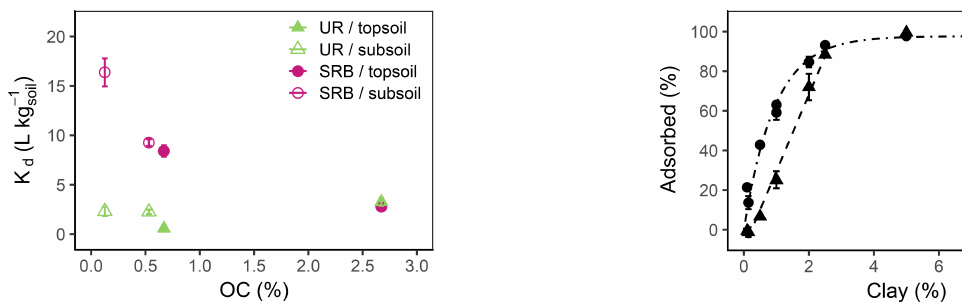
Figure 6. Adsorbed percentage as a function of the clay content for UR (triangles) and SRB (circles) in the sediment ( n = 18 for data points at 0.14%, 1% and 2% clay addition and n = 1 for all other data points). The error bars represent the standard deviation. The dashed line is the linear regression line of UR adsorption and the dot-dashed line is the exponential regression line of SRB adsorp-